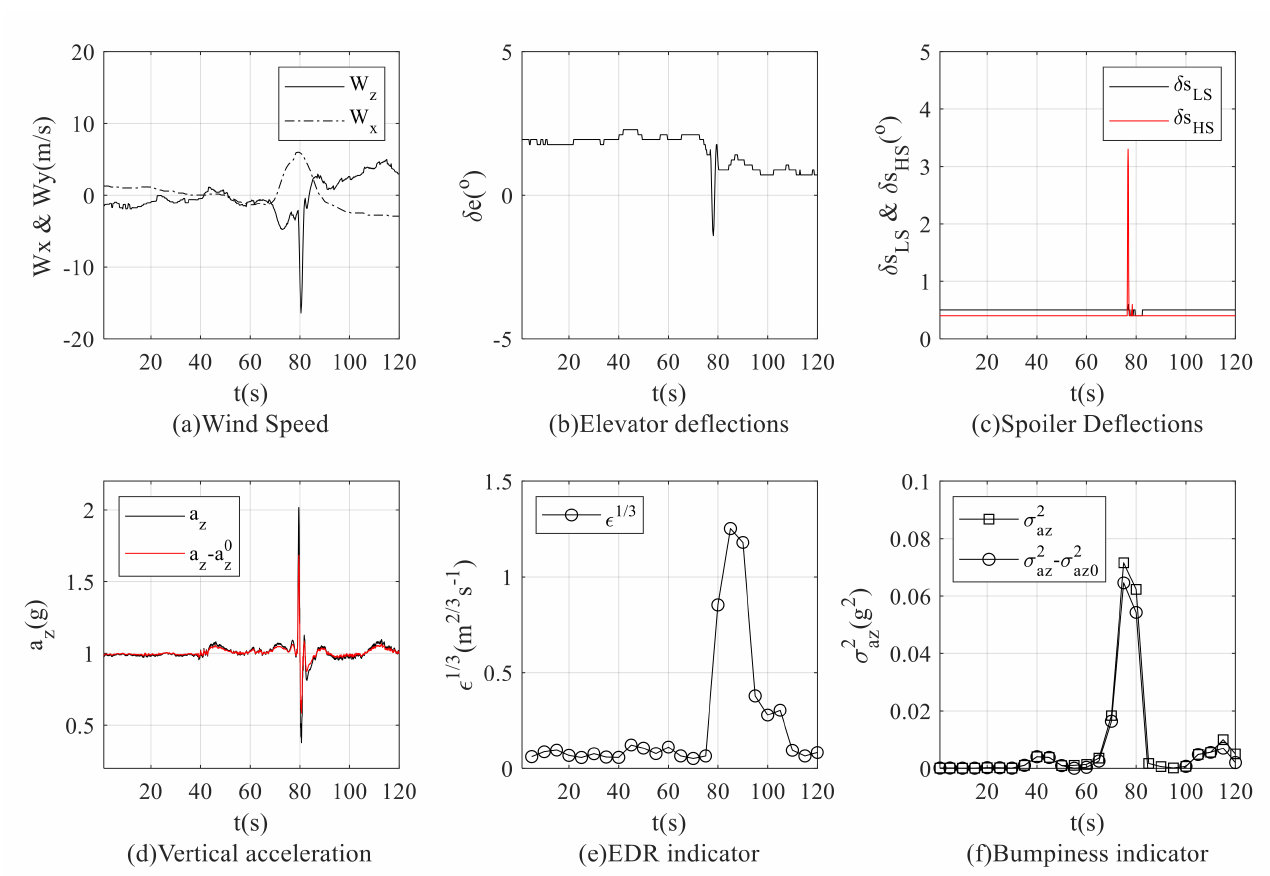
Figure 12. Aircraft maneuvers effects on Eddy Dissipation Rate (EDR) and bumpiness severity